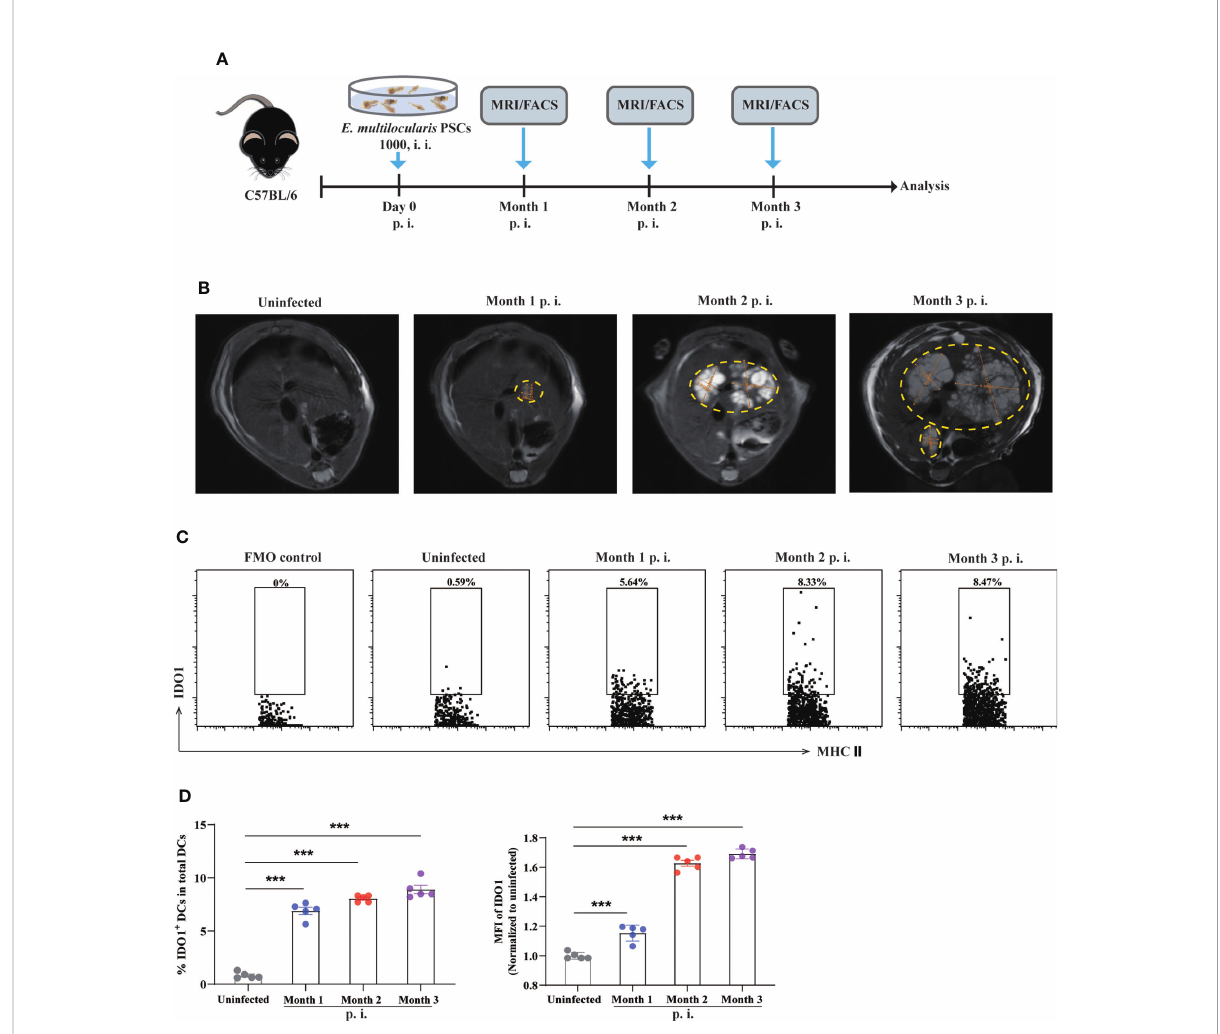
FIGURE 1 Expression of IDO1 on splenic DCs in murine E multilocularis infection model. (A) Schematic representation of the experimental setup. (B) Representative MRI images of metacestode tissue in the liver from E multilocularis – infected mice, and metacestode tissues were manually encircled with dashed yellow lines. (C) Representative fl ow cytometry plots of IDO1 on splenic CD11c + MHC II + DCs in infected and non-infected C57BL/6 mice (n = 5/group). (D) The frequency of IDO1 expressing splenic CD11c + MHC II + DCs derived from infected mice and non-infected controls (n = 5/group). Splenic CD45 + MHC II + CD11c + cells were gated. Data are pooled from 2 independent experiments, and presented as the mean ± SEM. ***, p< 0.001. PSCs, protoscoleces; p.i., postinfection; i.i., intraperitoneal injection; MRI, magnetic resonance imaging; MFI, median fl uorescence intensity; FMO, full minus one staining